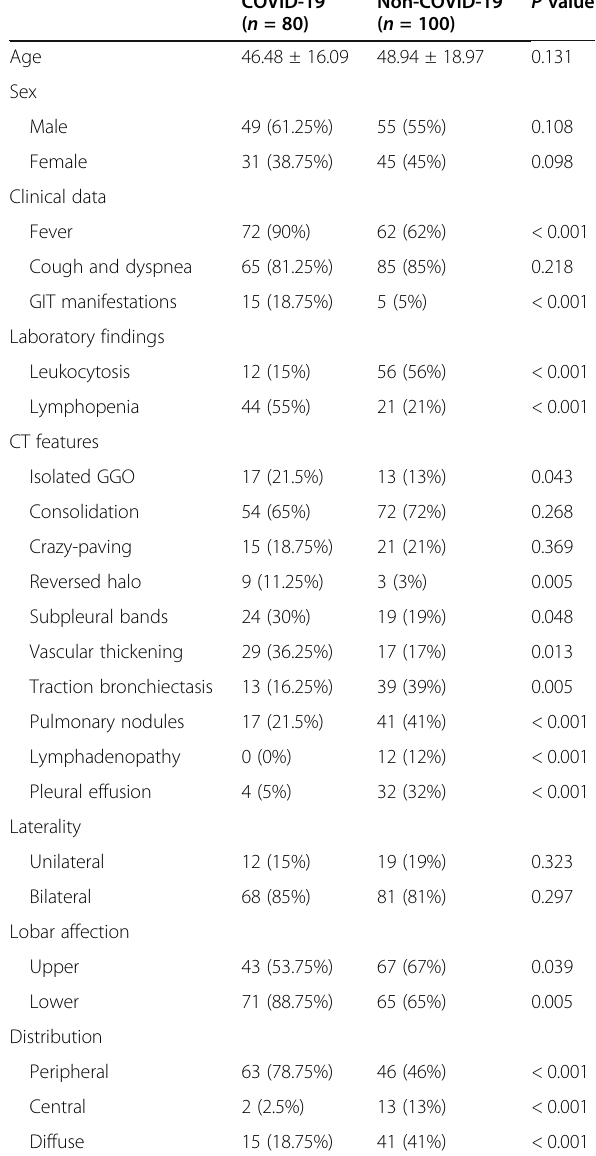
Table 2 Patients ’ demographics, clinical characteristics, laboratory data, and imaging features of both